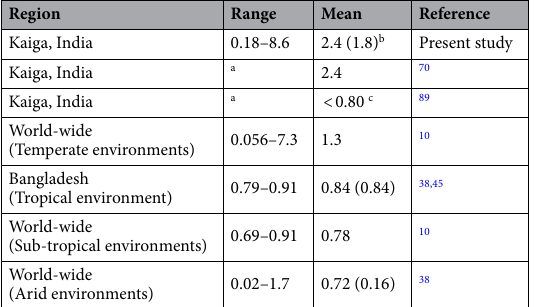
Table 3. Comparison of the Sr F v values for grass. a Data not available. b Value within the parenthesis represents GM. c Denotes the F v values for 90 Sr.